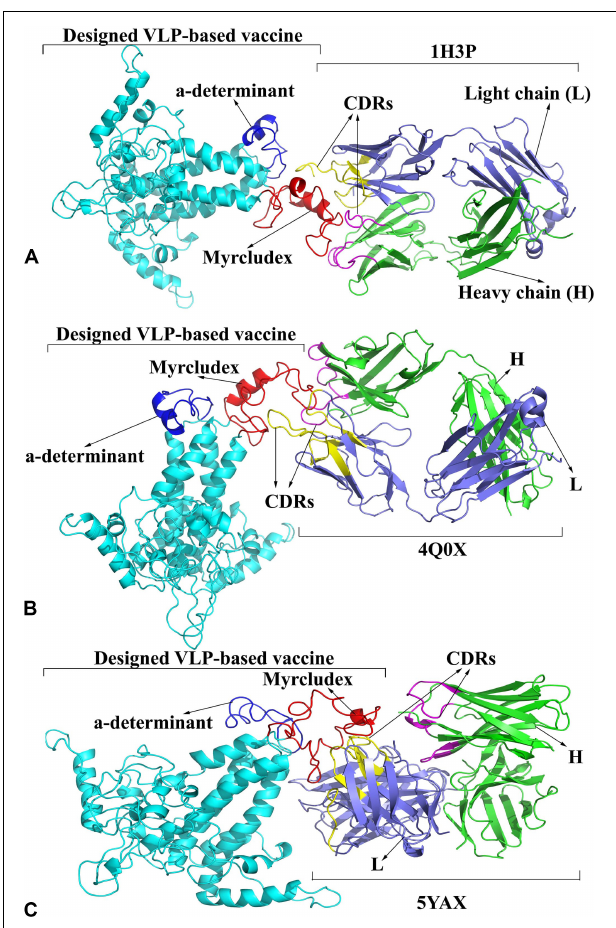
FIGURE 7 | Binding model of the designed virus-like particle (VLP)-based vaccine and antibodies. (A) 1H3P-designed vaccine complex. (B) 4Q0X-designed vaccine complex. (C) 5YAX-designed vaccine complex. The heavy and light chains of antibodies are colored in green and slate blue , respectively. The complementarity determining regions (CDRs) of the H and L chains are displayed in magenta and yellow , respectively. The designed vaccine, Myrcludex, and the “a” determinant are reflected in cyan , red , and dark blue , respectively.